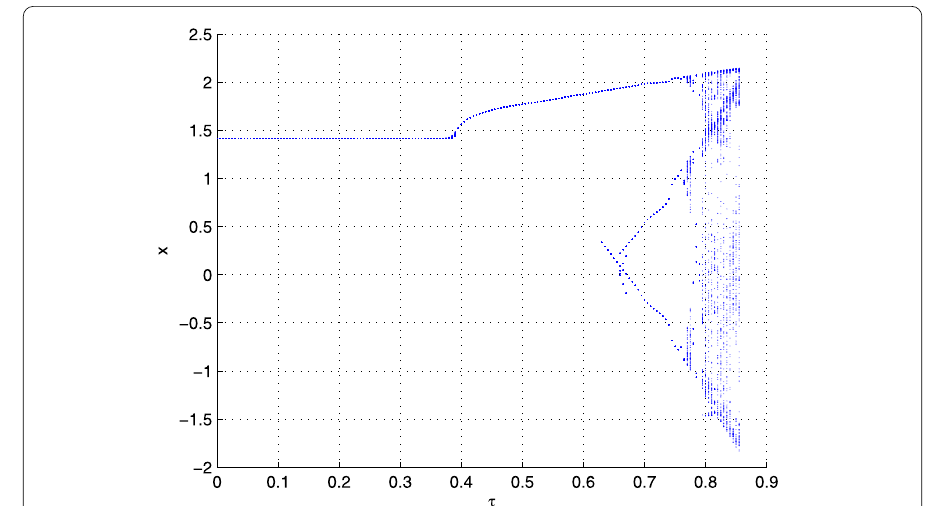
Figure 8 The bifurcation diagram of system (17) with the parameter γ = 2